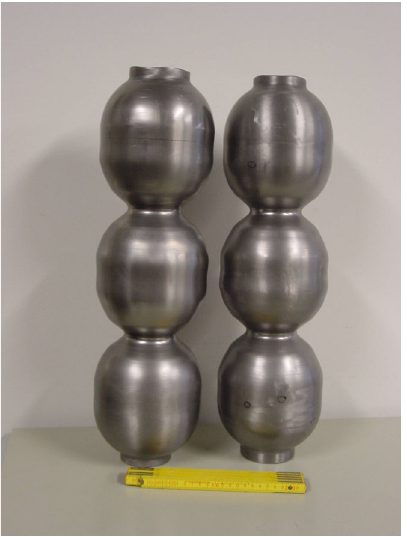
FIG. 8. (a) Principle of profile ring movement during the end cell necking. (b) Principle of the profile ring movement during iris necking.